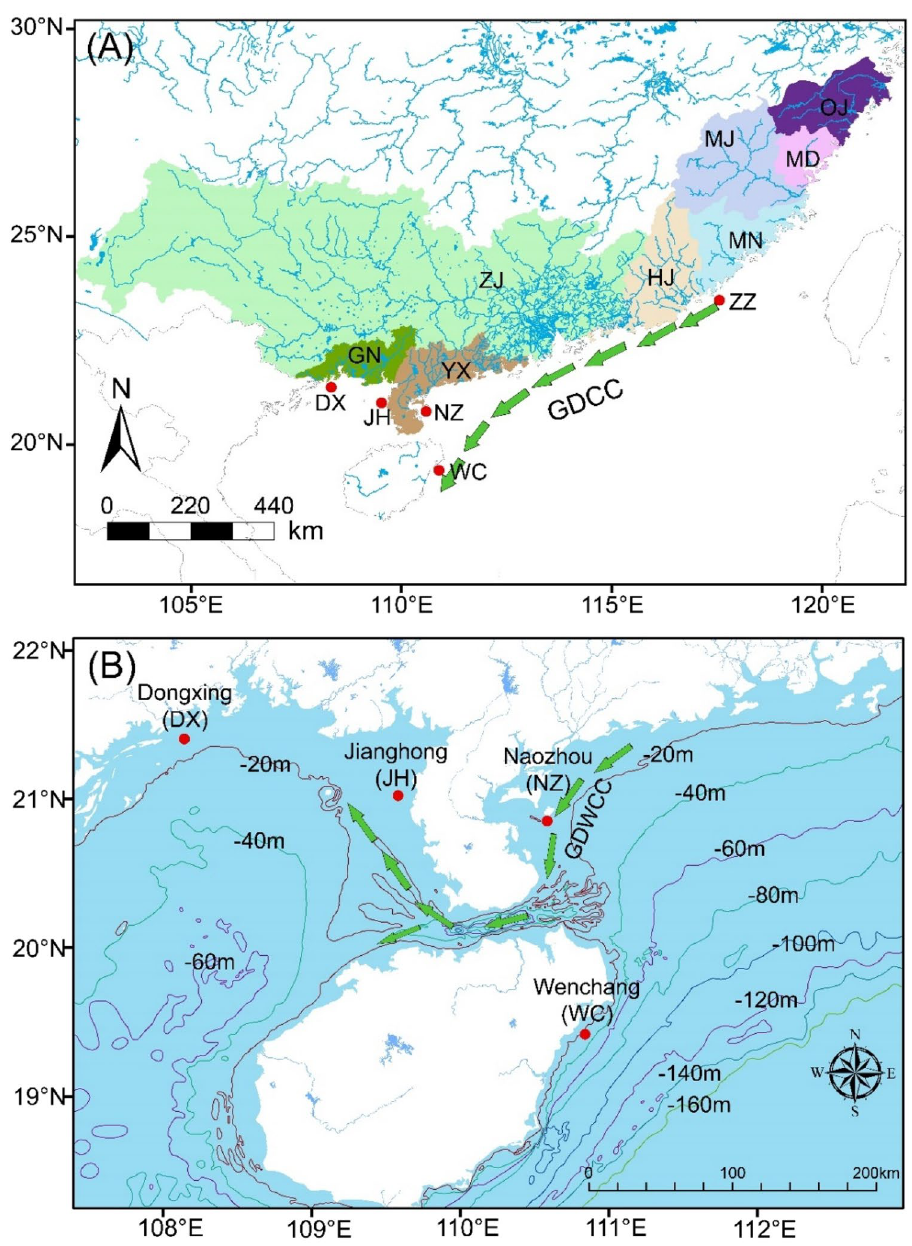
Figure 1. The locations where the fourfinger threadfin, Eleutheronema tetradactylum , were collected. ( A ) The different colored areas on the land represent the different basins along the southern coast of China, Oujiang Basin (OJ), Mindong Basin (MD), Minjiang Basin (MJ), Minnan Basin (MN), Hanjiang Basin (HJ), Zhujiang Basin (ZJ), Yuexi Basin (YX), Guinan Basin (GN). Red dots show the sample sites. ( B ) The green arrow symbol is the schematic representation of currents. The map was drawn using open source software QGIS 2.14 (http:// www. qgis. org/). The base map was downloaded from the Natural Earth (open access) at https:// www. natur alear thdata. com/. The boundary of different basins was extracted from HydroBASINS at https:// www. hydro sheds. org/ produ cts/ hydro